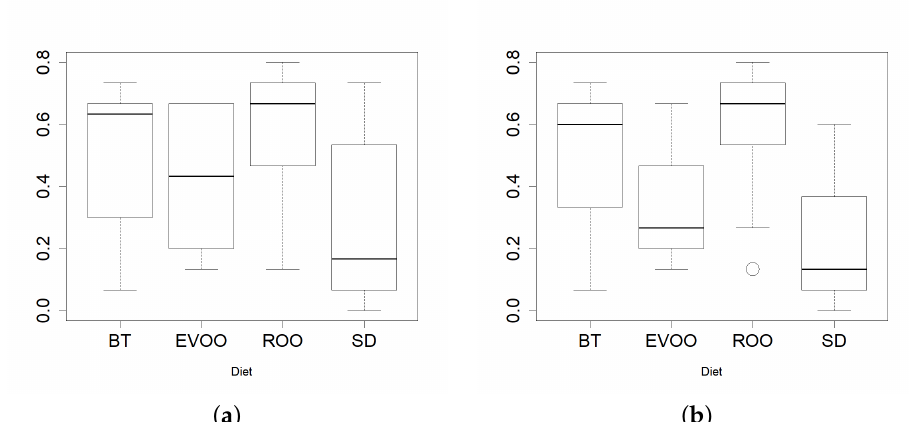
Figure 5. Boxplots of percentage of resistances in each strain grouped by diet considering all time-points; ( a ) p SD vs. ROO = 0.0225) or without initial time data; ( b ) p SD vs. ROO =